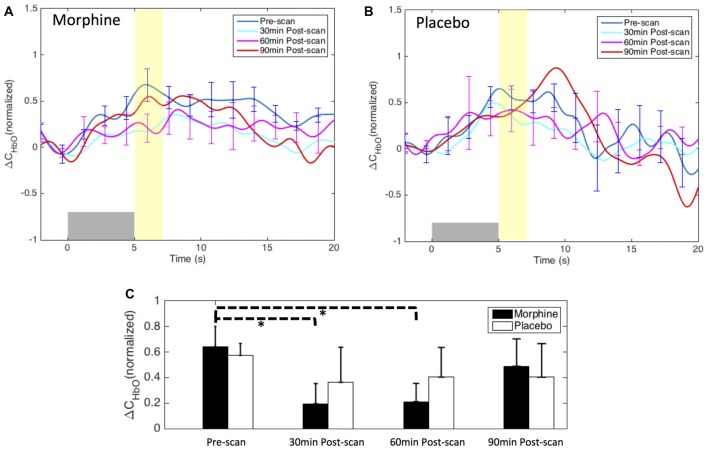
Morphine and placebo effects on the fNIRS-measured S1 responses to noxious stimuli. Top panel: the HRFs to noxious stimuli (VAS7) over the right S1 during visits in which oral morphine (A) or placebo (B) was administered. Gray bars indicate the time period when noxious electrical stimuli were applied. Bottom panel: (C) bar plots of the averaged HRF magnitudes (from 5 s to 7 s after the onset of the stimulus) in each scan session. P-values showing statistically significant attenuation in the averaged magnitudes are marked in the figure, *p < 0.05. All error bars show the standard error of the mean.